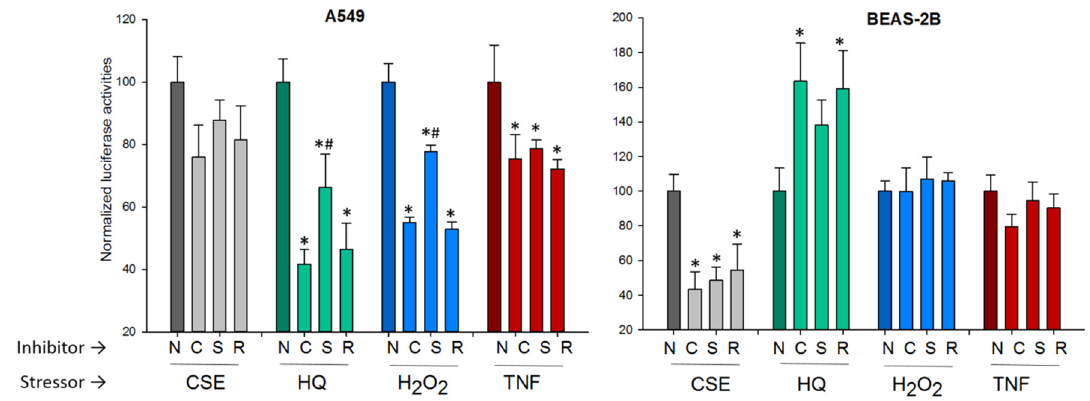
Figure 10. Effects of CMC (C), (4 S )-CMCO (S), and (4 R )-CMCO (R) on activation of AP-1 by stressors in A549 and BEAS-2B cells. The luciferase activities in the treated cells are normalized for the reporter activity in wells receiving no inhibitor (N). The stressor concentrations are indicated in Figure 6. The inhibitor concentrations were 1 mM in all experiments. The error bars are SDs; n = 3. The di ff erences of means were probed by the one-way ANOVA; * indicates a statistically significant di ff erence between an inhibitor treatment and “no inhibitor” control; # indicates a statistically significant di ff erence between CMC and CMCO treatments, p < 0.05.